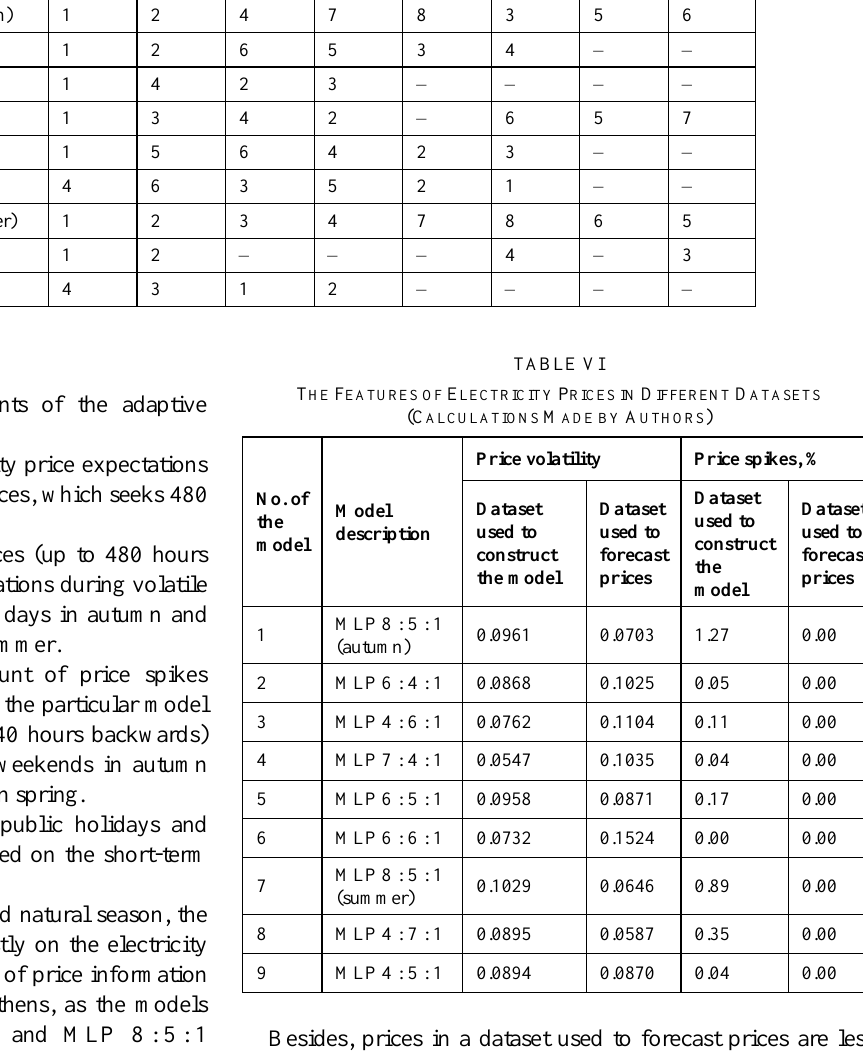
R ESULTS OF R ANKING THE D ETERMINANTS OF THE A DAPTIVE E LECTRICITY P RICE E XPECTATIONS (C ALCULATIONS M ADE BY THE A UTHORS ) No of the Model description model